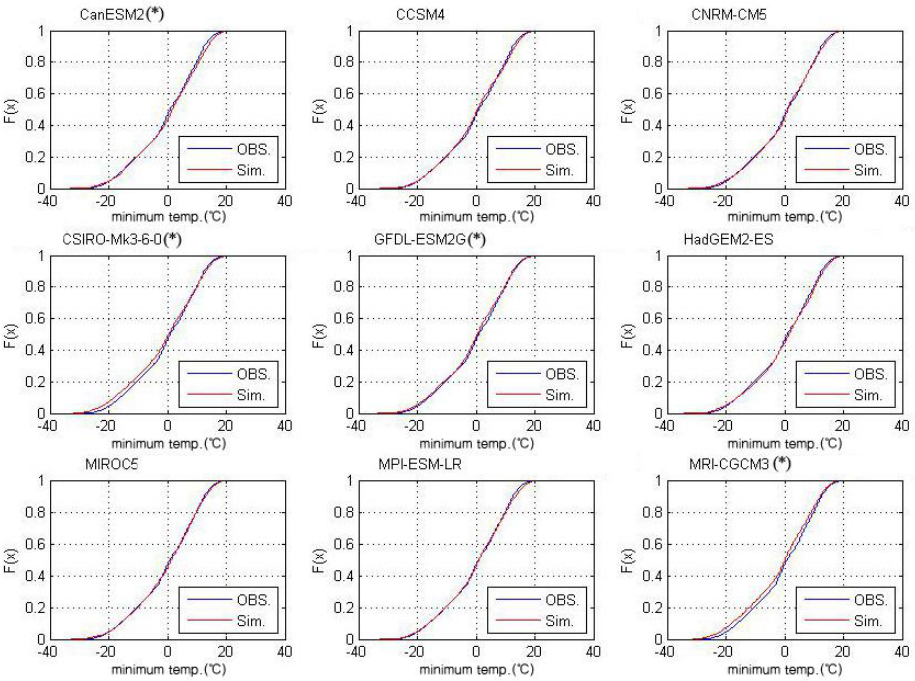
Figure 6. Two-variable Kolmogorov–Smirnov test (95% significance level) for RCP 2.6 for last 20 years (1994 to 2014): (*) indicated that the GCMs result identified as different distribution with observed.